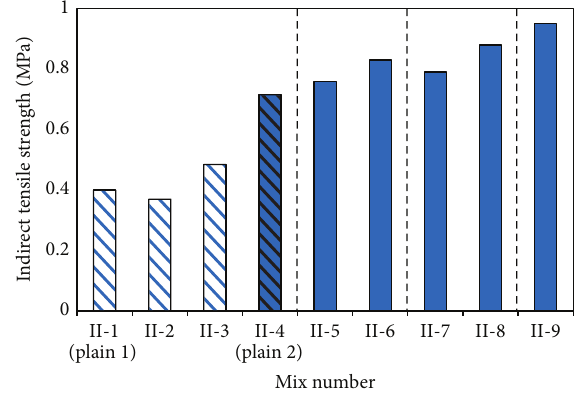
Figure 7: Indirect tensile